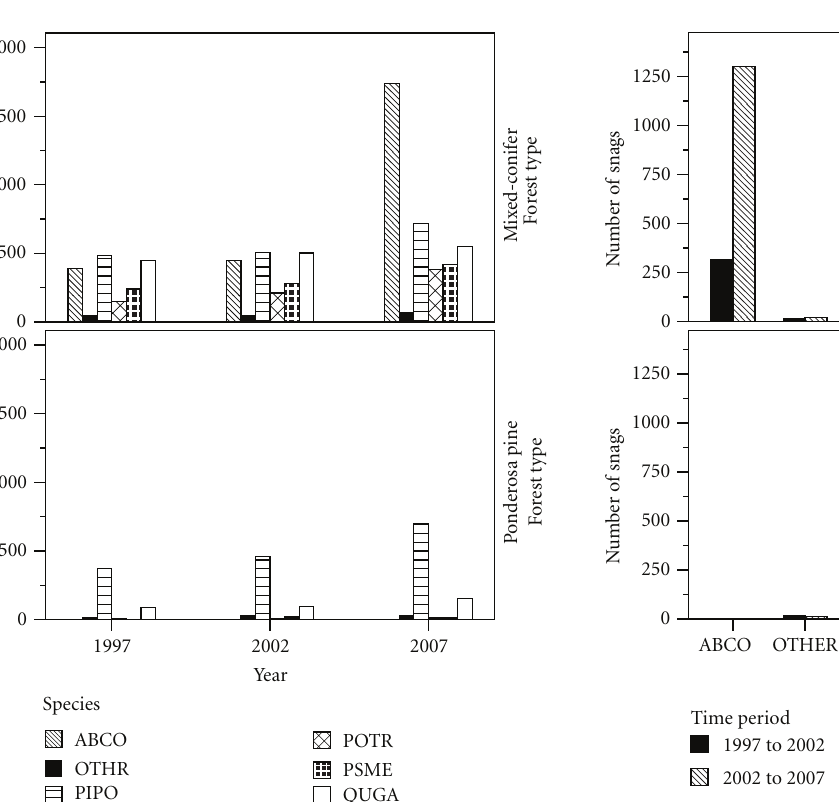
Figure 7: Species composition of snag populations in northern Arizona mixed-conifer and ponderosa pine forest in 1997, 2002, and 2007. Species acronyms: ABCO: white fir, PIPO: ponderosa pine, POTR: quaking aspen, PSME: Douglas-fir, QUGA: Gambel oak, and OTHR: all other species.